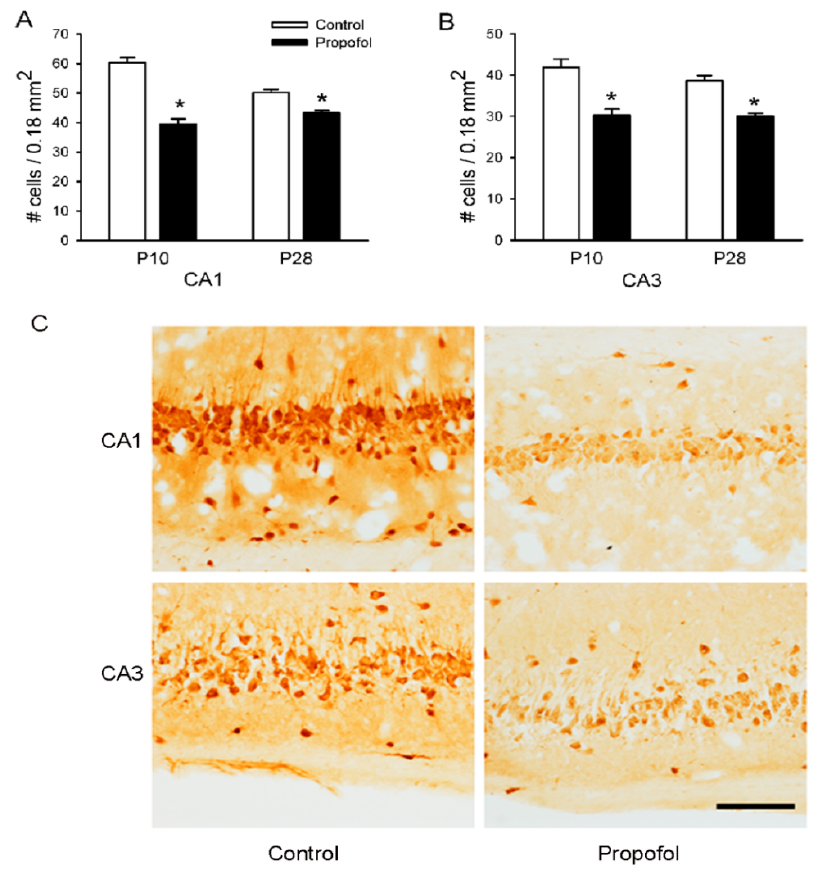
Figure 4. Propofol administered to pregnant rats reduced the number of NeuN-positive neurons in the CA3 and CA1 regions of the hippocampus of the offspring rats. The number of NeuN-positive neurons in the hippocampal CA1 ( A ) and CA3 ( B ) regions of pups on P10 and P28 were counted. Data from six pups per group ( N = 6, 1 offspring per litter, n = 6) are expressed as means ± SEM. * p < 0.001 significant difference from age-matched control group. ( C ) Representative photomicrographs of NeuN-positive neurons in the CA1 and CA3 regions of pups on P28. Scale bar = 50